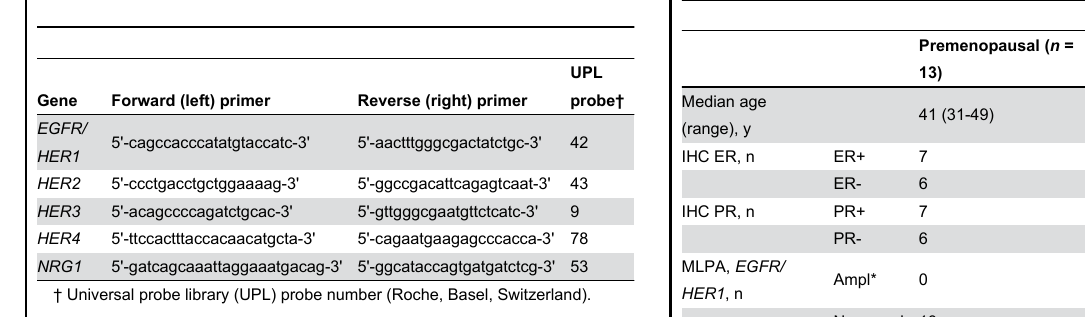
Table 2. Patient and tumour